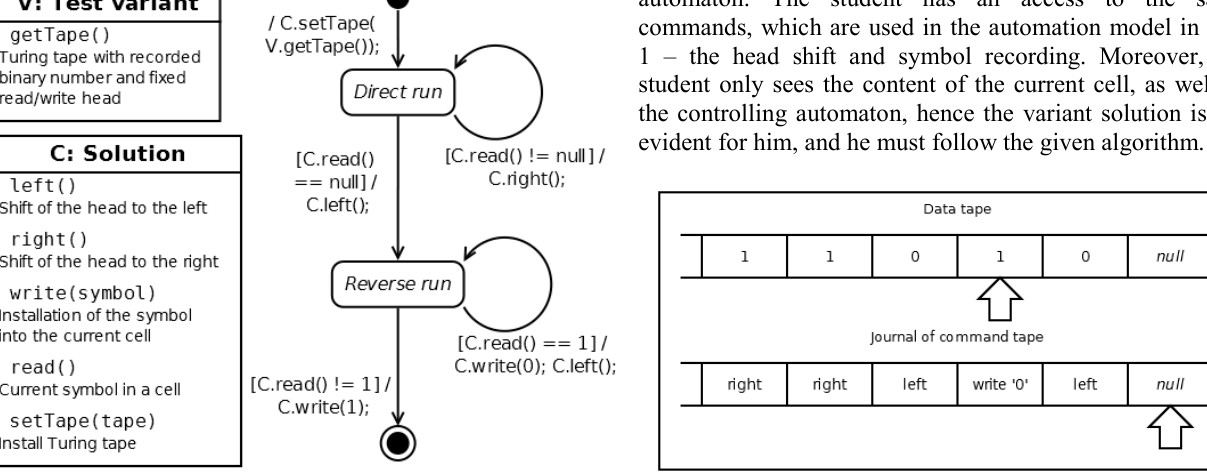
Figure 1. Automation model of the algorithm of increasing an integer by a unit for Turing machine